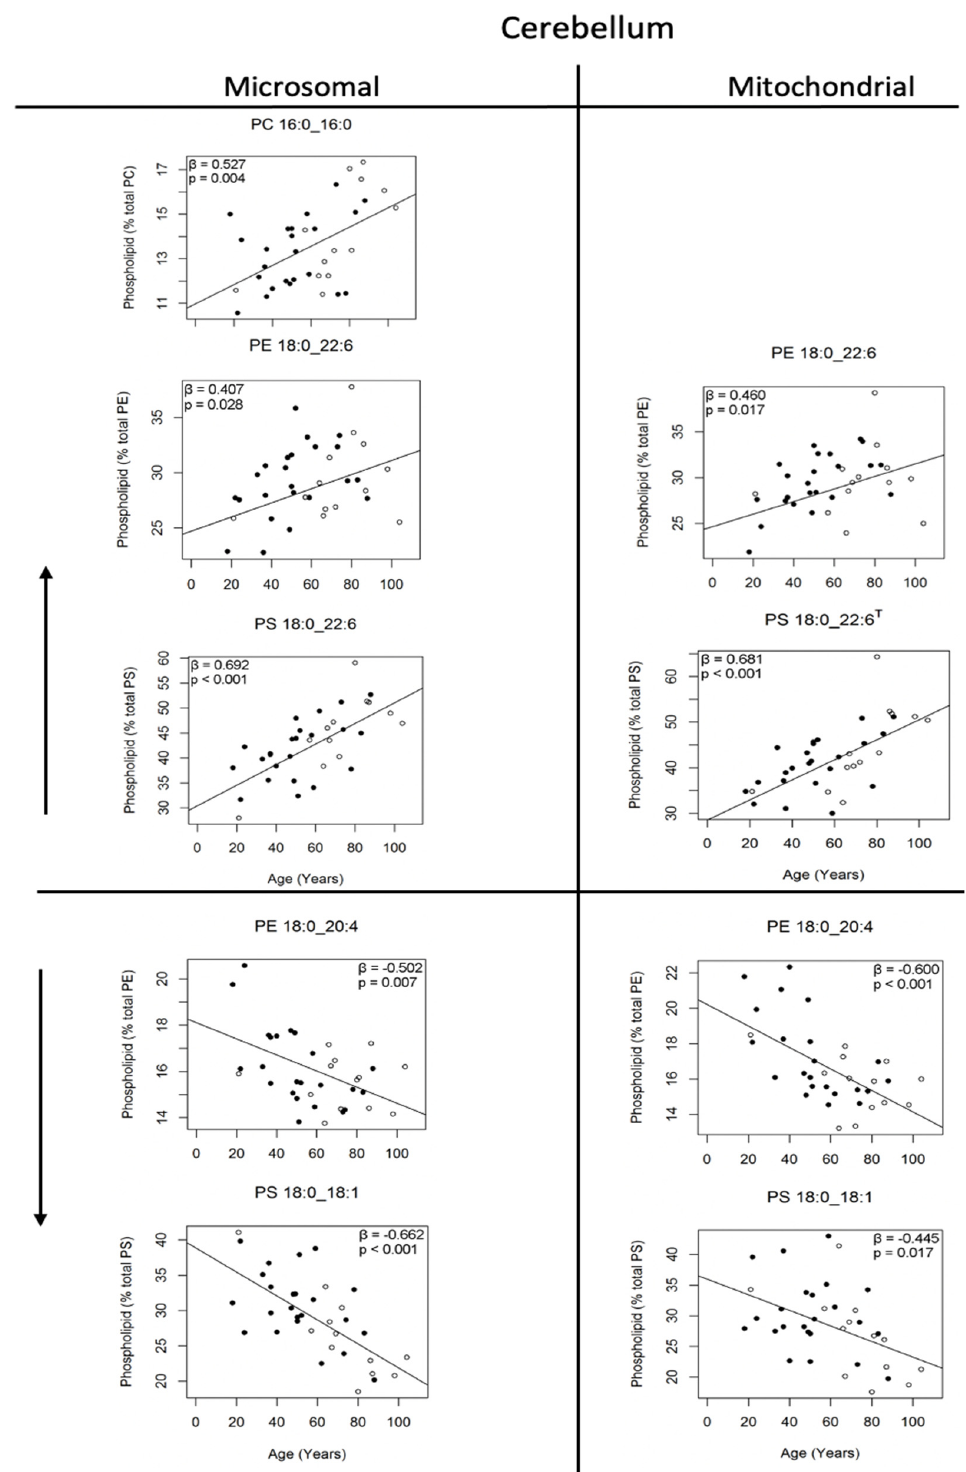
Figure 1. Phospholipids of the cerebellum, representing greater than 10% of each phospholipid class, that changed significantly in the microsomal and mitochondrial membranes with age; T indicates dependent variables transformed for linear regression. Regression models were adjusted for sex: males ( • ) and females ( ). The beta coefficient and p value are provided on each plot ( n = (cid:35)